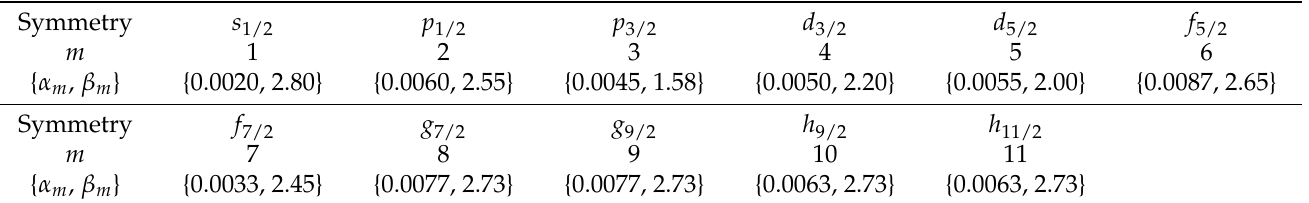
Table 1. Even-tempered exponents are used in our relativistic calculations. We extend Huzinaga’s non-relativistic exponents [60] for relativistic